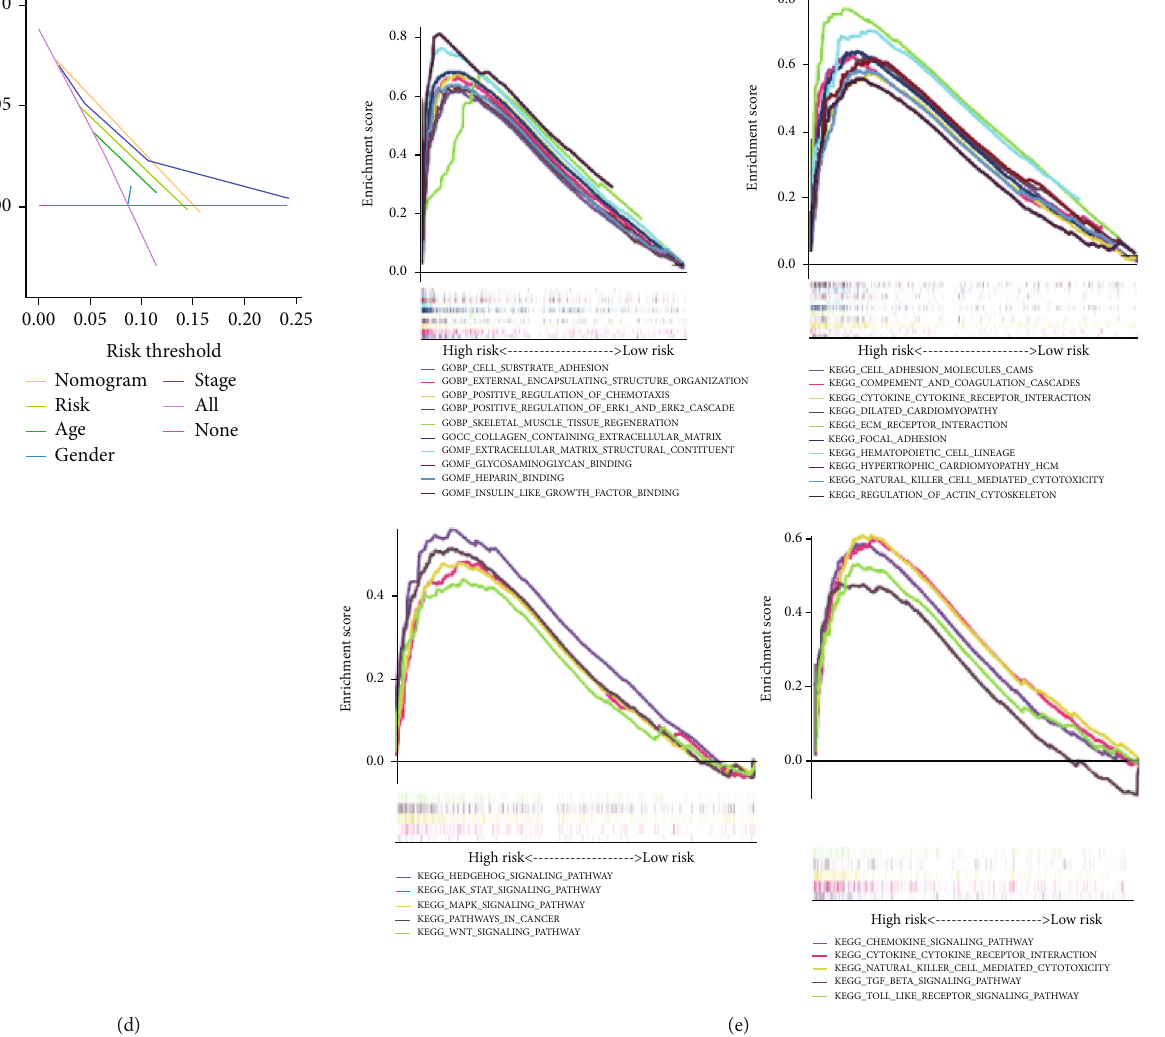
Figure 6: Establishment and validation of the nomogram. (a) The nomogram for predicting the 1-, 3-, and 5-year OS of CRC in the cohort based on the risk score and other clinical factors. (b) Principal component analysis (PCA) plot for nrlncRNAs. (c) Calibration plots for assessing the accuracy of the 1-, 3-, and 5-year survival rates. (d) Decision curve analysis (DCA) diagram of nomogram and other clinical factors. (e) GSEA of the top 10 pathways of GO and KEGG database signi fi cantly enriched in the high-risk group and of the tumor-associated and immune-associated pathways signi fi cantly enriched in the high-risk